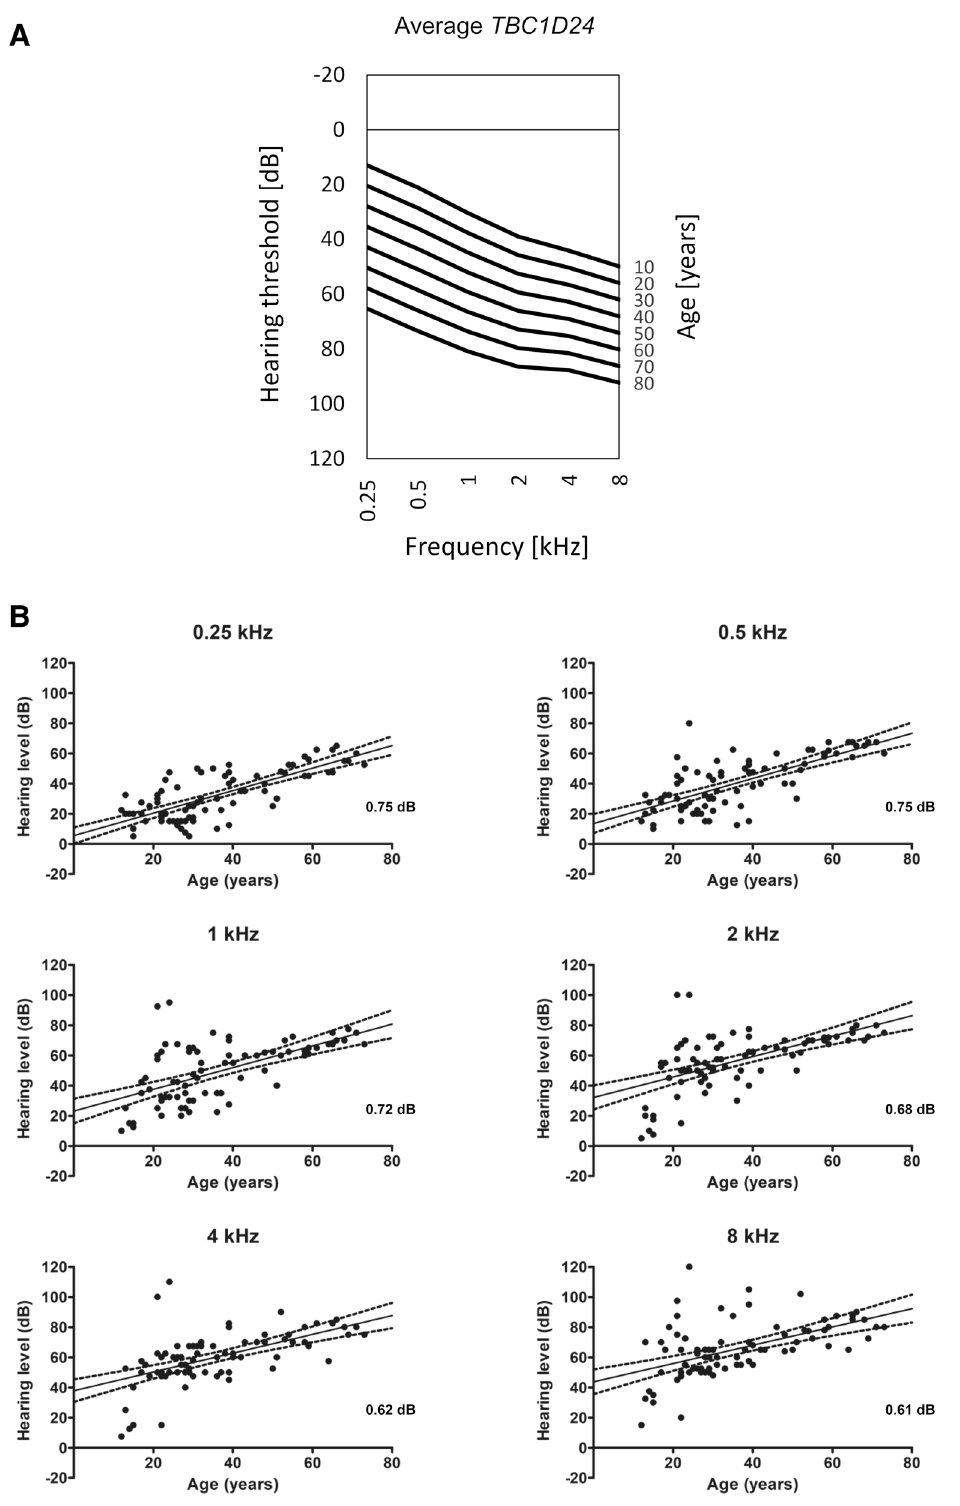
Figure 2. Audiological characteristics of TBC1D24 -related ADHL. ( A ) ARTA for patients with TBC1D24 pathogenic variants. ( B ) Rate of HL deterioration in